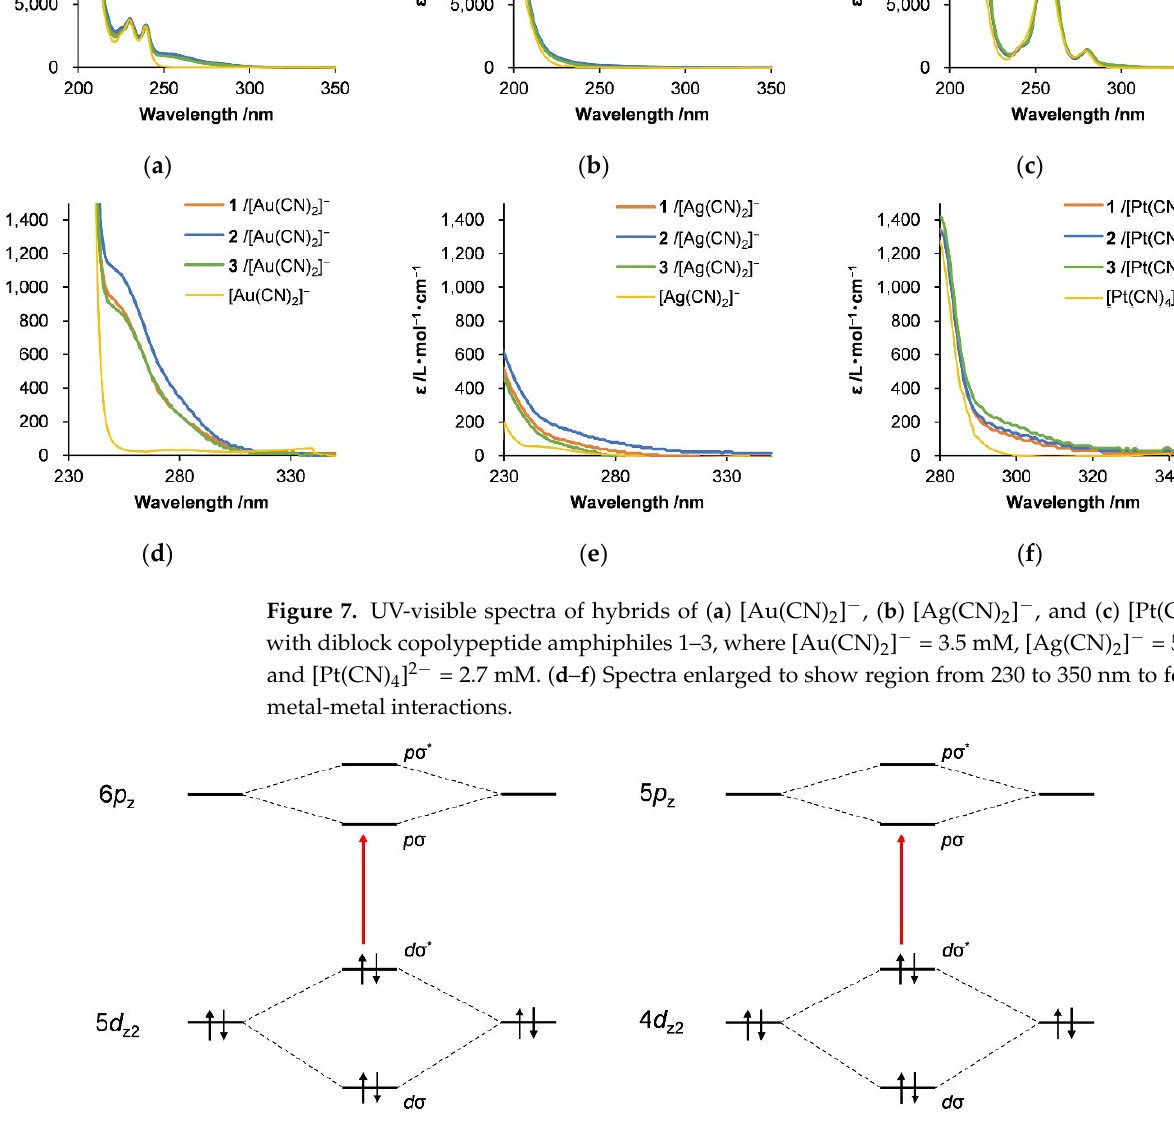
Figure 8. Molecular orbital diagrams for ( a ) Au(I), Pt(II) and ( b ) Ag(I) in cyanometallate complexes showing effective metal-metal electronic interactions based on z-axis stacking.